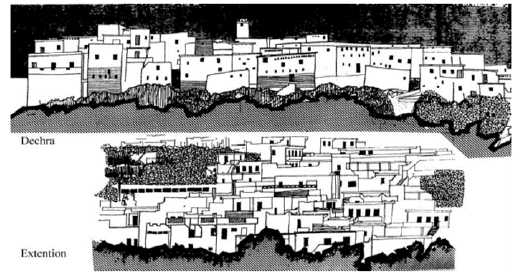
Figure 11. Transformations in the urban landscape of Menaa. BENABBAS